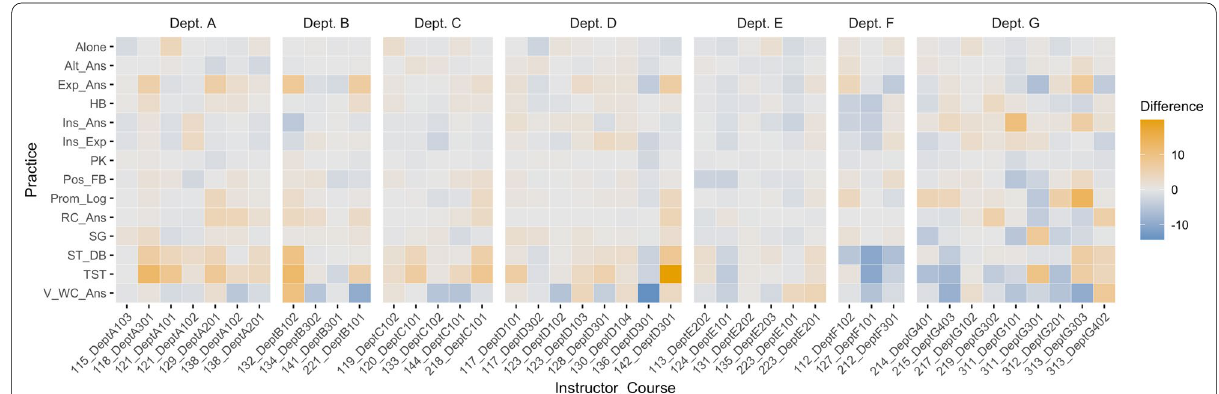
Fig. 3 Changes in average values of PORTAAL practices from T1 to T2. Each column represents the difference in average value of each PORTAAL practice between timepoints one and two for a paired course. Each x -axis label refers to a Fellow and the paired course they taught. The de-identified course numbers reflect the course level. If the same course was taught by multiple Fellows, the de-identified course number is the same. See Table 2 for the long descriptions of the code names of the PORTAAL practices shown on the y